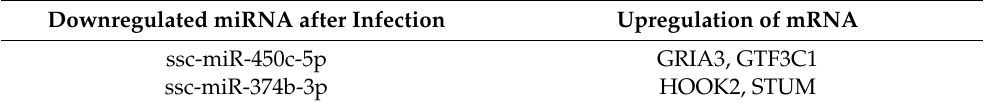
Figure 7. Pathways associated with differentially expressed miRNA target genes identified by KEGG enrichment analysis. Each point in this figure is a KEGG pathway, the ordinate text indicates the pathway name of KEGG, and the classification description is such as the Class legend information on the right. The abscissa is expressed as the enrichment rate, and the formula is as follows: (Enrich_factor = GeneRatio/BgRatio). A larger figure indicates a greater number of differentially expressed genes. The color indicates the significance of the enrichment, which is the p -value; a darker color indicates a more enriched pathway, and the color gradient on the right indicates the p -value size. Table 4. Target genes corresponding to the downregulated miRNA after